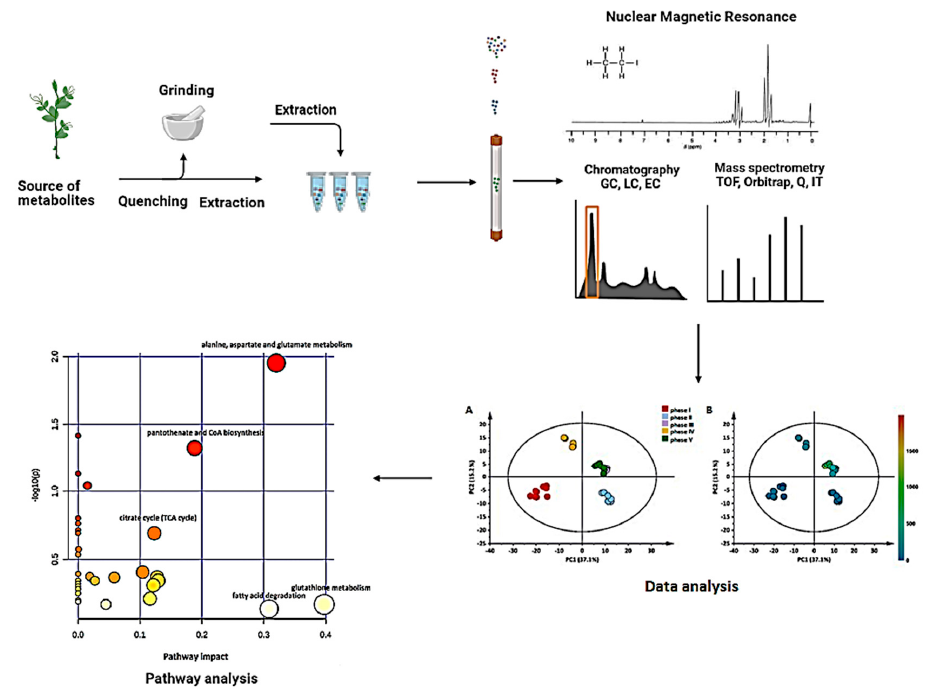
Figure 2. Workflow of a metabolomics approach. Figure created using BioRender (https://bioren ‐ der.com/).